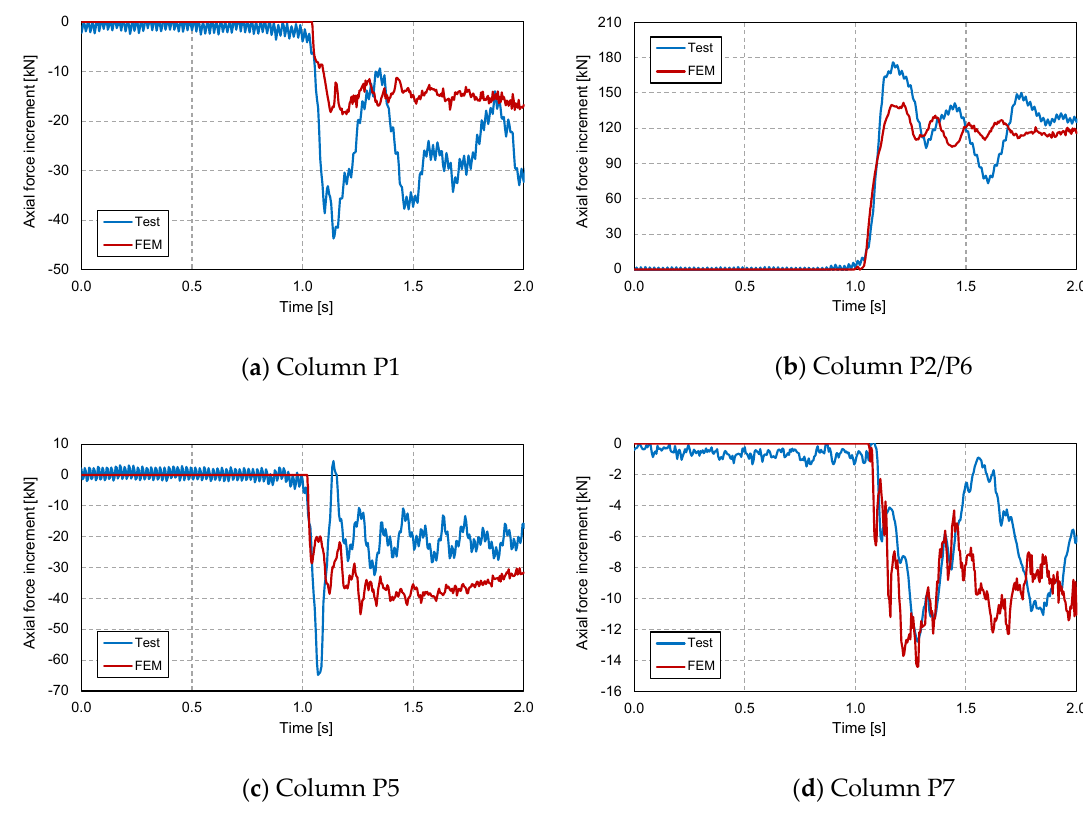
Figure 5. Comparison of the test [28] and FE model for the axial force increments in columns P1, P2 / P6, P5 and P7. Positive values indicate compression.